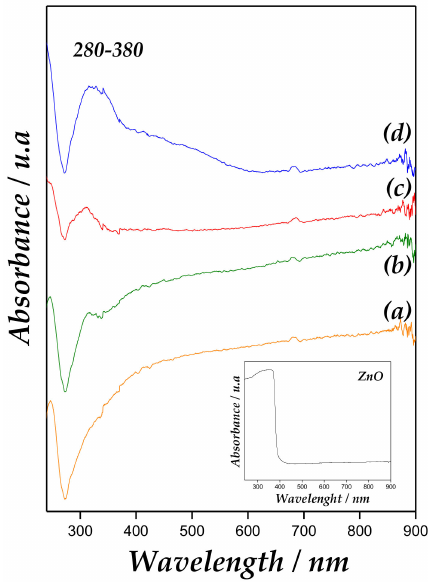
Figure 4. Diffuse Reflectance Ultraviolet-Visible Spectroscopy (DRUV–Vis) spectra of (a) Zn/MCM-41(1), (b) Zn/MCM-41(2.5), (c) Zn/MCM-41(10), and (d) Zn/MCM-41(15) catalysts.